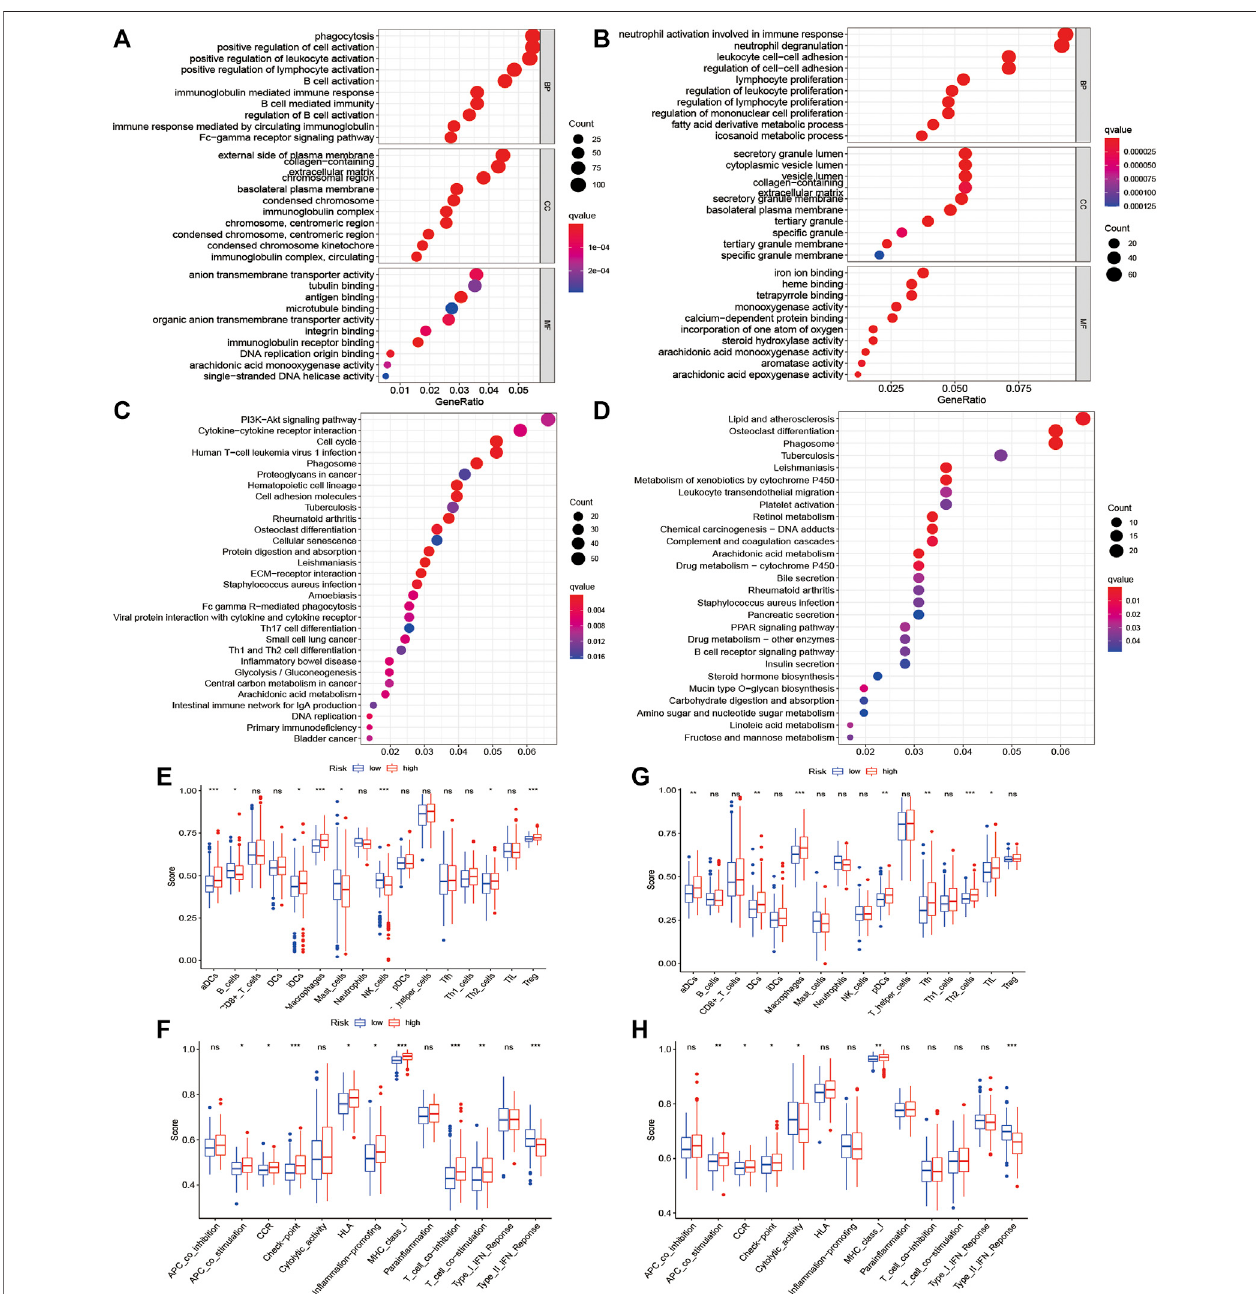
FIGURE6| Functional enrichmentanalysisoftwo risksubgroups inthe TCGA cohort and ICGC cohort. (A – D) GOenrichmentand KEGG pathway analyses in the TCGA cohort and ICGC cohort. (E – H) Levels of diverse immune cell subpopulations and immune-related functions in the TCGA cohort and ICGC cohort.